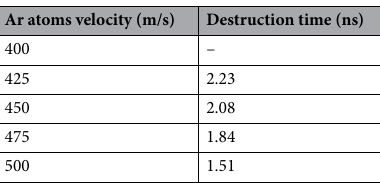
Table 5. The destruction time of CNT (7,7) with 5 nm length as a function of Ar atoms velocity.